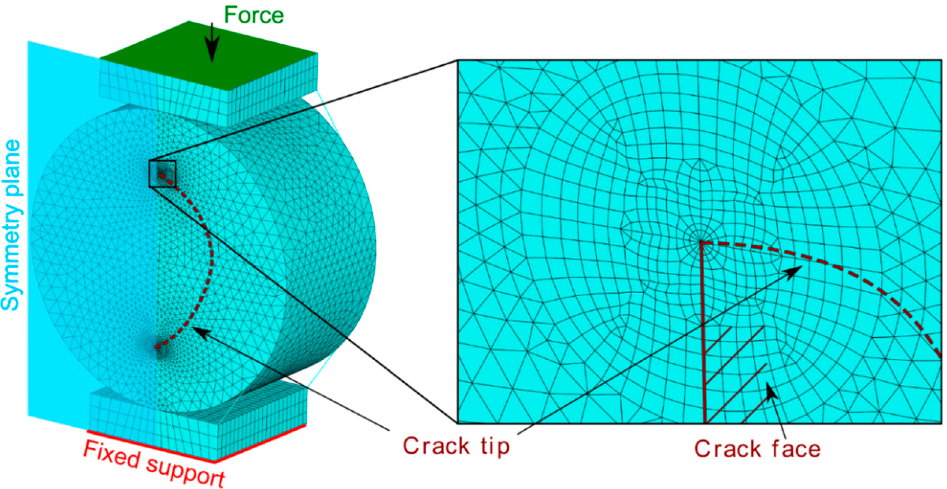
Figure 2. The mesh of the whole symmetrical FEM model of the bearing cylinder. The refined area in the vicinity of the crack tip is pictured in the detail view (note the special crack tip elements in the middle).